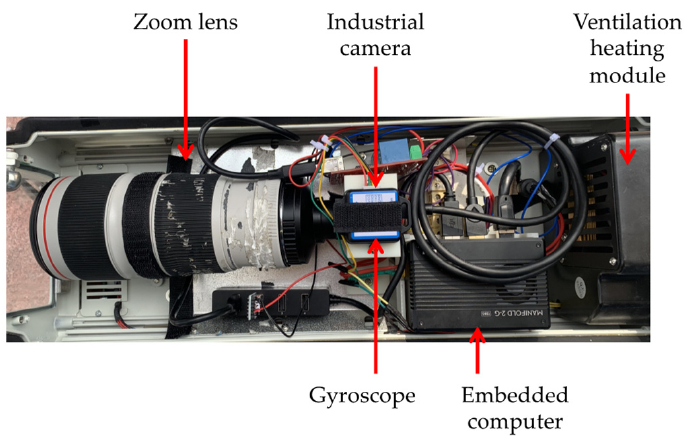
Figure 15. Integrated camera set used in this study.